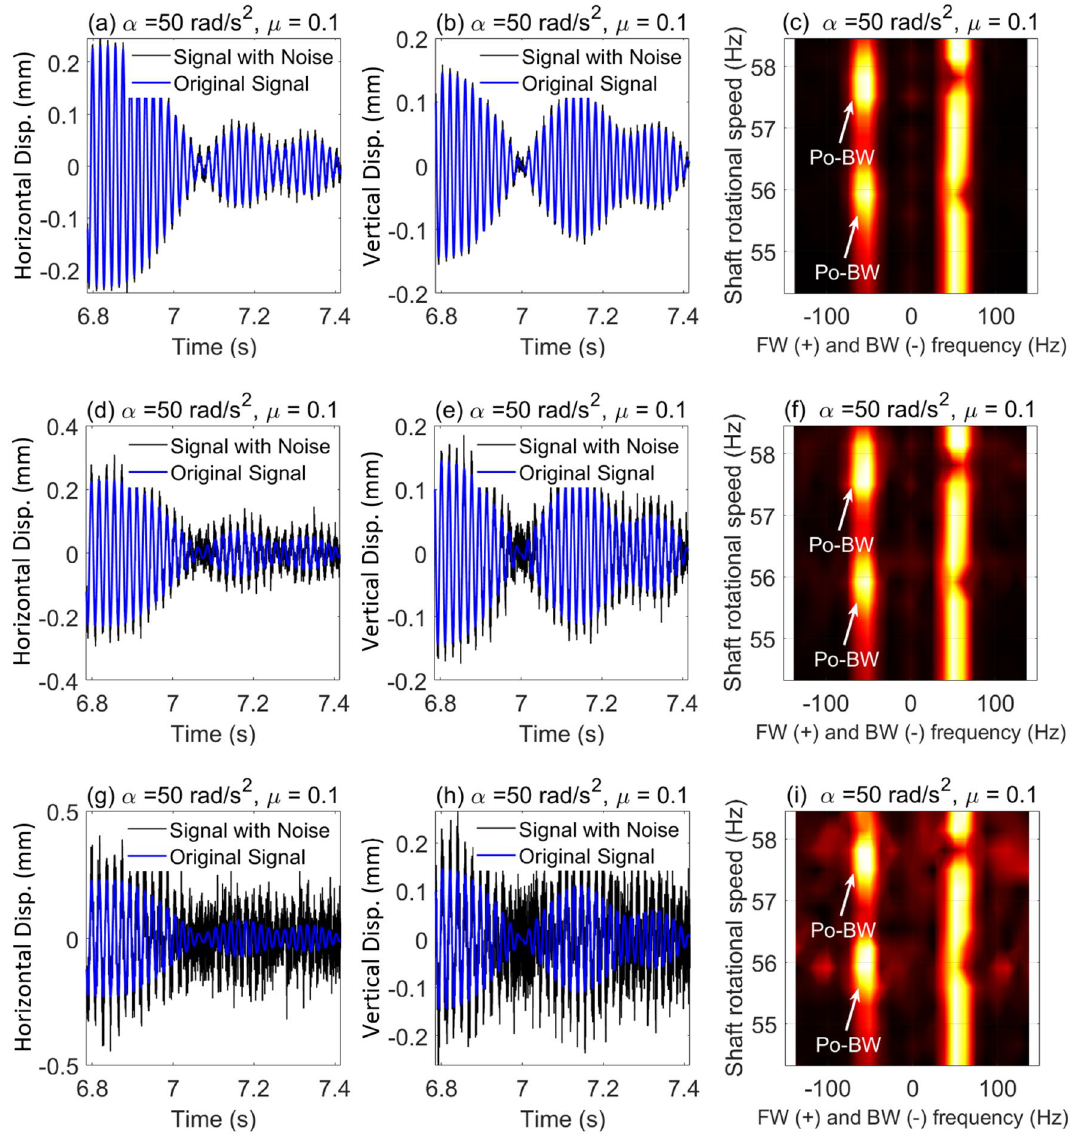
Figure 13. Incorporation of noise in displacement response and FSA plots for the cracked overhung rotor in element 5, at SNR = 20 dB in ( a – c ); SNR = 10 dB in ( d – f ); and SNR = 1 dB in ( g – i ratio. Nevertheless, the intensity of Pr-BW zones is much smaller compared with Pr-BW zones for the cases with cracks located in the third and fourth elements. For subsequent Fig. 14c,d with cracks located at the third and fourth elements, respectively, we notice a gradual increase in Pr-BW and Po-BW intensities by further shifting the crack location closer to the rotor midspan and at relatively high values of the crack depth ratios. The Po-BW recurrence and intensities remain roughly the same at the low crack depth ratio range. Generalizing the above findings, it can be said that the behavior of both Pr-BW and Po-BW zones will need to be assessed together in order to diagnose the location of crack. For high intensity Po-BW zones, the crack is more likely to be located closer to the left bearing. As the crack position is shifted toward the center, Pr-BW zone undergoes significant changes, and hence it could serve as a discriminating feature for determining the possible location of the crack. Further research is needed to achieve accurate correlations between crack locations and backward precession zones. In the remaining analysis the crack location is assumed to be in element 3 between the bearings. For this crack location the Po-BW zones in the whirl response are shown in Fig. 14c. Therefore, the corresponding whirl 0.1 are shown in Fig. 15. Four Po-BW response and wavelet transform spectrum of the frequency content at µ = zones get excited as shown in Fig. 15a with frequency content on the left and the wavelet frequency spectrum on the right in Fig. 15b. It is observed that the frequency content in this Po-BW zones is less than the resonance frequency of the system. Similar to the results in Fig. 13 where the crack location was in element 5, for crack location in element 3, an artificial random noise is added here to the simulation response data for the case in Fig. 15. For high SNR value